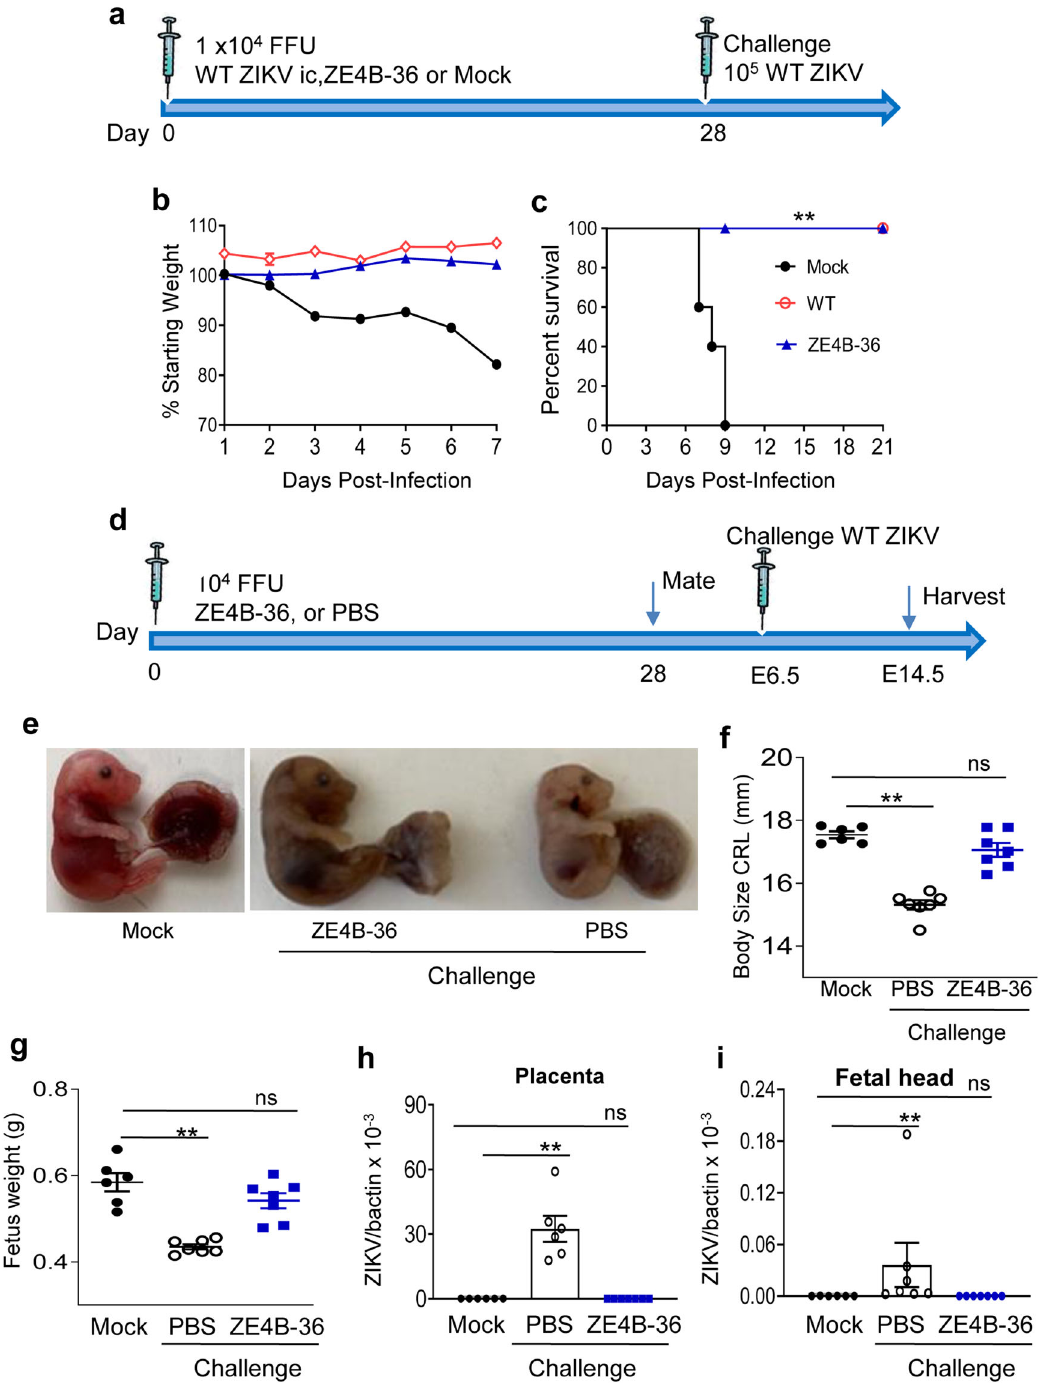
Fig. 5 Vaccination with ZE4B-36 protects mice from subsequent WT ZIKV challenge and maternal to fetus transmission. a – c Four- to 6- week-old AB6 mice were infected i.p. with 1 × 10 4 FFU WT ZIKV FSS13025ic, ZE4B-36 or PBS (mock). On day 28, all surviving mice were challenged with 1 × 10 5 FFU WT ZIKV FSS13025. a Schematic of active vaccination and challenge. b Mouse weight loss. c Survival rate. Weight loss is indicated by percentage, using the weight on the day before immunization to de fi ne 100%. n = 5, 4, and 10 for PBS, WT, and ZE4B-36- infected mice, respectively. d – i Female AB6 mice were immunized with 10 4 FFU of ZE4B-36 or PBS. At day 28 post immunization, vaccinated female mice were mated with AB6 males. Pregnant mice were challenged with 5 × 10 5 PFU ZIKV-PRV strain at E6.5. On E14.5, animals were euthanized and fetal size, eight and viral loads were measured. Mock group represents pregnant mice without vaccination and challenge. d Experimental schematic. e Representative image of E14.5 fetuses. The size ( f ) and weight ( g ) of 7 fetuses at E14.5. h , i Viral load in placentae and fetal heads collected from 6 to 7 fetuses per group. Data are presented as means ± standard error of the mean (s.e.m). ** P < 0.01 compared to mock group (unpaired t